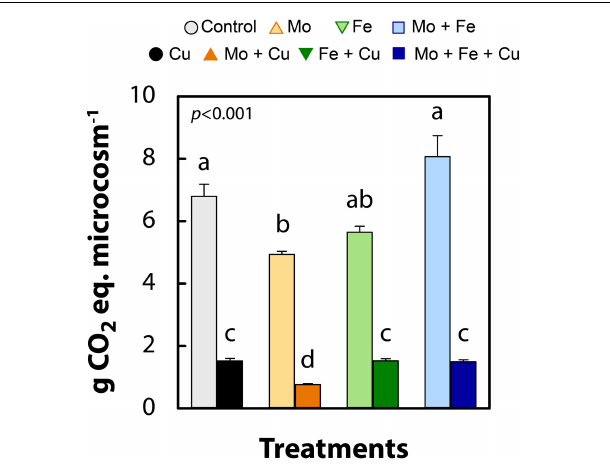
FIGURE 4 | Global warming potential in g of CO 2 equivalents (g CO 2 -eq) of cumulative gas concentrations (96 h) of nitrous oxide, methane, and carbon dioxide in anoxic slurries amended with molybdate (Mo), iron (Fe), copper (Cu), and combinations thereof. Data are shown as mean ± standard error ( n = 4). Letters indicate significant differences as determined by Kruskal–Wallis and Bonferroni post hoc